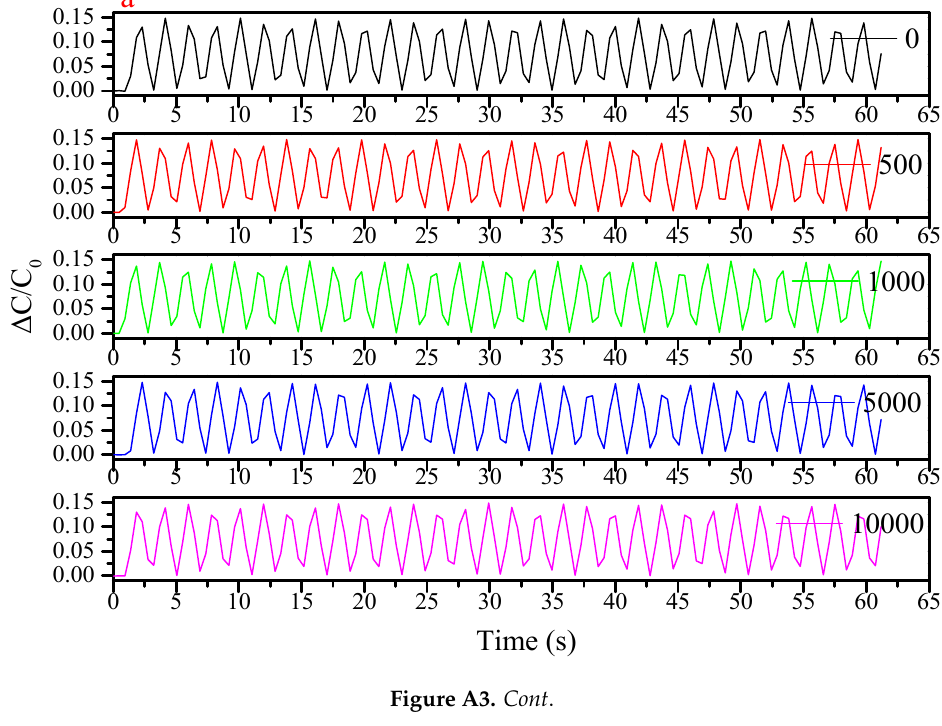
Figure A2. Placement of sensor on silicone in vitro stomach model—anterior wall of body.